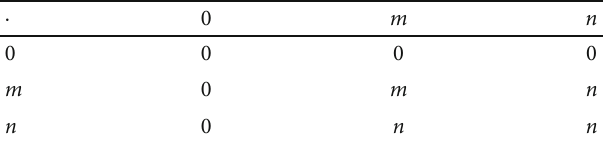
Table 2: Ternary